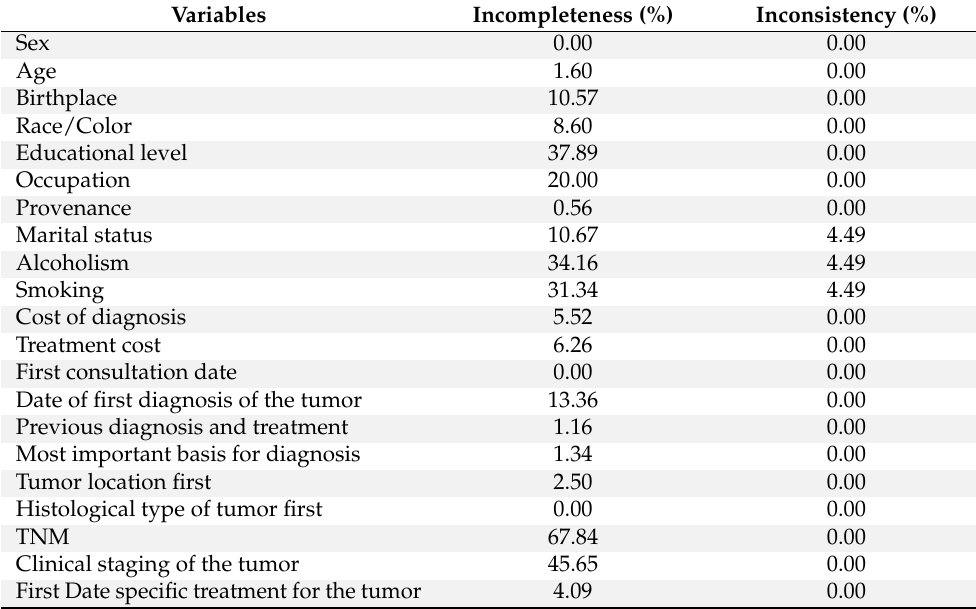
Table 4. Inconsistency of variables, according to the proportion of cases without information and proportion of non-existent codes, respectively, HCR/ES